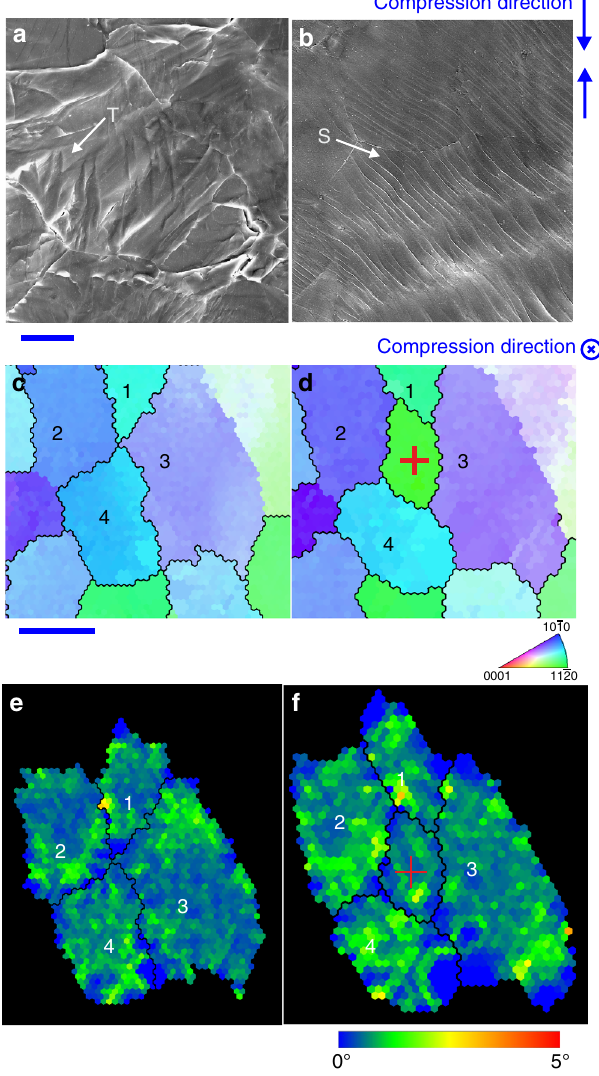
Fig. 4 Microstructure evolution during cold compression. Secondary electron micrographs showing a deformation twins (T) and b slip traces (S) in a specimen extruded at 400 °C and compressed by 20%. c , d Quasi-in- situ electron backscattered diffraction maps showing the same cross- section area of a specimen extruded at 80 °C c before and d after 6% compression in the direction perpendicular to the cross-section area. An extra grain, marked by red cross, has appeared in the area after the compression. e , f Kernel average misorientation maps of c , d qualitatively showing strain distribution in individual grains. 0° indicates low strain and 5° high strain. The red cross grain has similar kernel average misorientation. Scale bars in a – c – f indicate 20 µ m and 500 nm, respectively